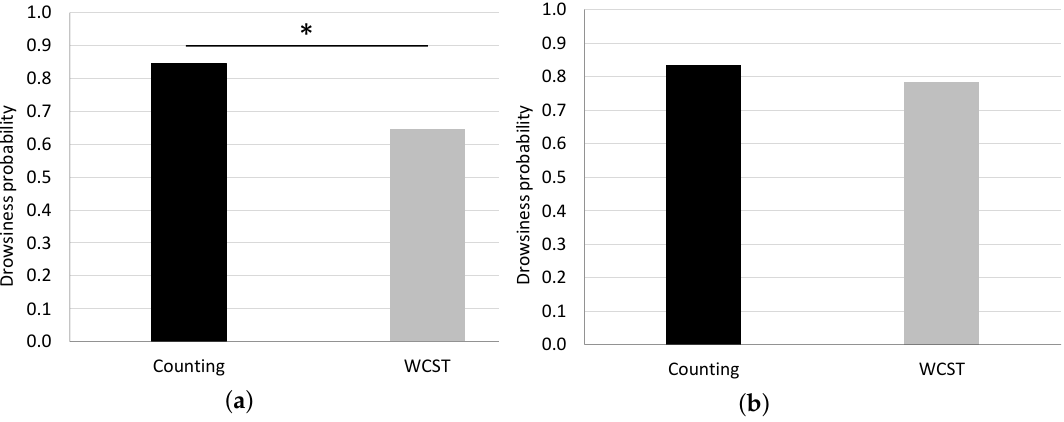
Figure 8. ( a ) The average drowsiness probability of the 20 subjects, as generated by the PSD (SWLDA) and SVM. Scores were significantly higher during the counting task (0.85 vs. 0.65, * p < 0.05); ( b ) the average drowsiness probability of the 20 subjects, as generated by the PSD (Theta, Alpha) and SVM. The average score was higher during the counting task (0.83 vs.